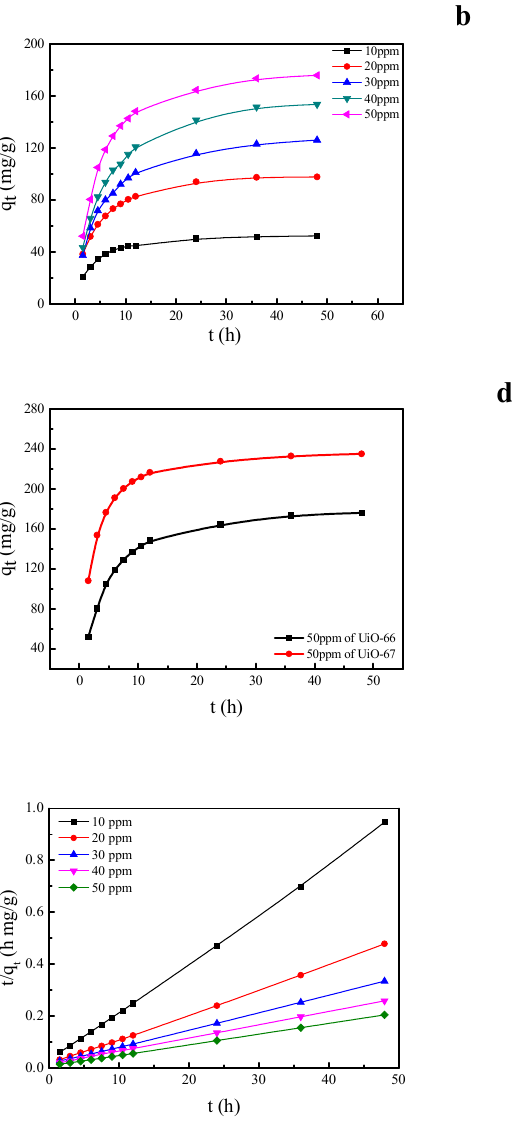
Figure 4. Effect of contact time and initial concentration of the AO7 aqueous solutions on the adsorptive capacity. ( a ) UiO-66, ( b ) UiO-67, and ( c ) UiO-66 and UiO-67 comparison of the maximum adsorption. Kinetic plots of t / q t vs. t for ( d ) UiO-66, ( e ) UiO-67. Table 1. Parameters of pseudo-second-order kinetics model for the adsorption of AO7 by UiO-66 at series initial concentrations.